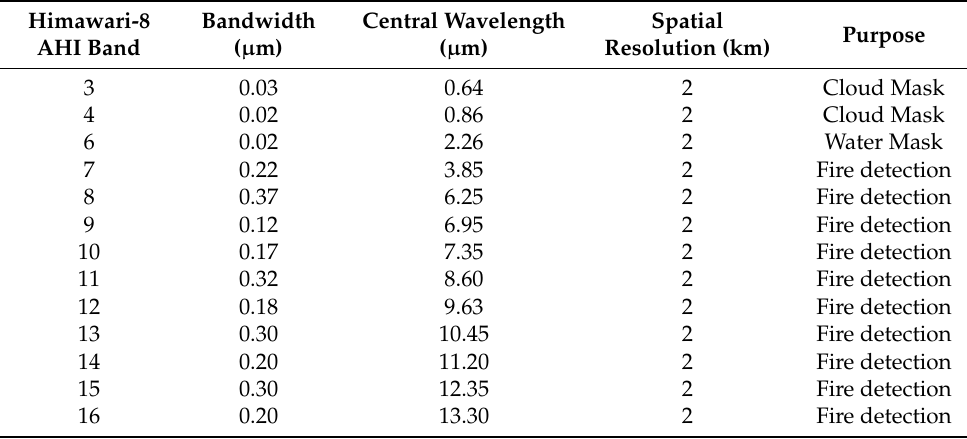
Table 1. Himawari-8 AHI bands used in this